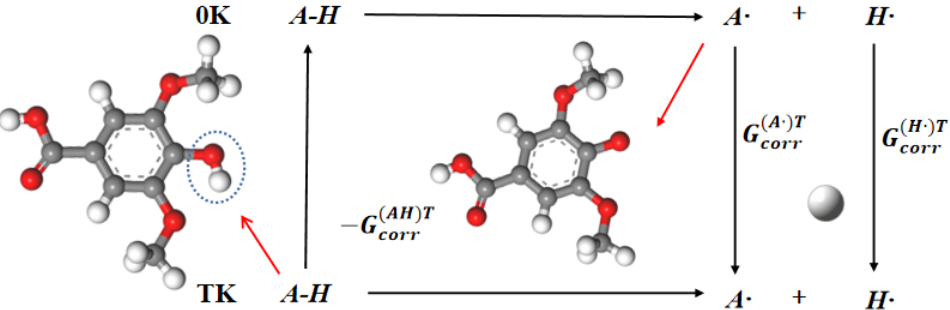
Figure 2. Example of the thermodynamic cycle for SA. (White spheres, red spheres, and gray spheres represent H atoms, O atoms, and C atoms, respectively).